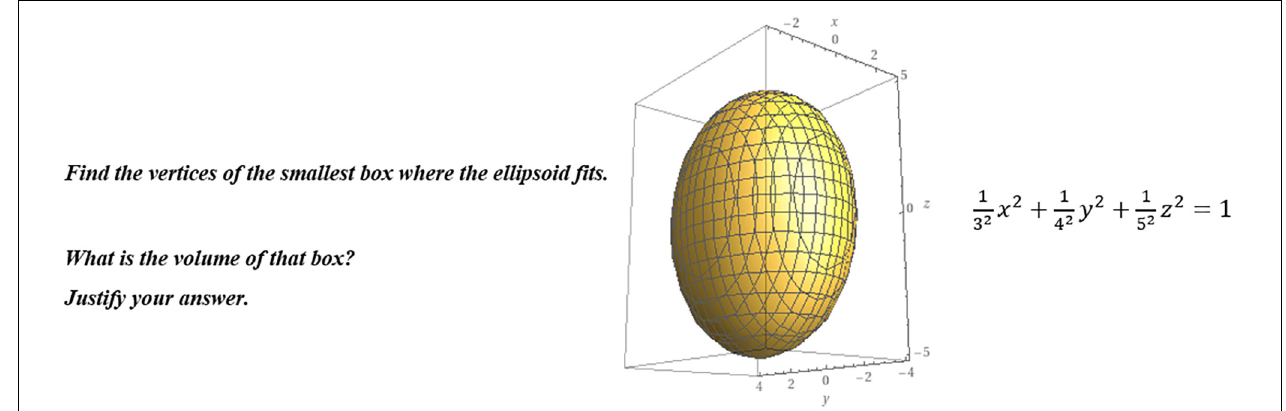
FIGURE 4 | A question that implies reasoning, logical thinking, and problem-solving skills to be answered.